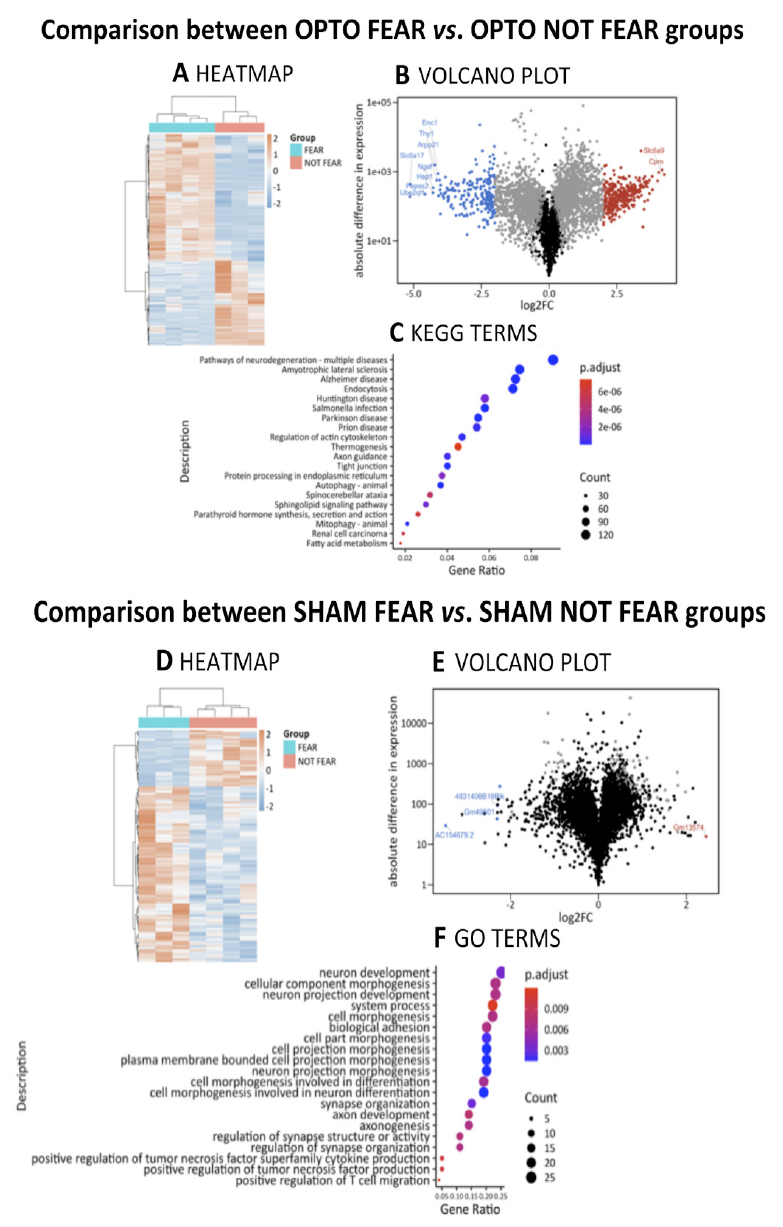
Figure 6. Differential Gene Expression profiling and functional enrichment analysis of RNA extracted by amygdala pyramidal neurons. Comparisons between OPTO FEAR vs. OPTO NOT FEAR groups (upper part) and SHAM FEAR vs. SHAM NOT FEAR groups (lower part). ( A , D ) Heatmaps showing gene expression values for the Differentially Expressed Genes (DEGs). ( B , E ) Volcano plots highlighting DEGs. The x -axis is the log2 fold change (log2FC) in normalized gene expression and the y -axis is for the log 10 absolute value of the difference in expression between conditions. Each dot represents a gene. Grey dots are for DEGs, blue and red dots are for < − 2 and > + 2 log2FC genes, respectively. The top ten genes with the highest absolute log2FC values are labeled. ( C , F ) Dot plots representing the top twenty enriched terms from over-representation analyses (ORA) in Gene Ontology (GO) and Kyoto Encyclopedia of Genes and Genomes (KEGG) databases. GO terms from different domains (Biological Processes, Cellular Component, and Molecular Function) were sorted by q -value before plotting them